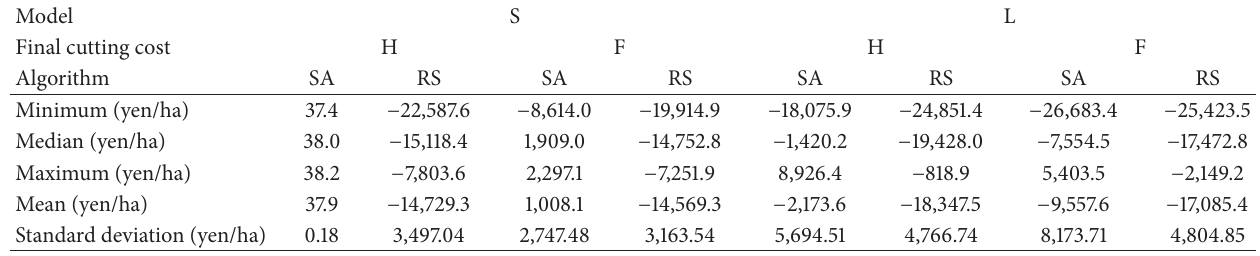
Table 2: Differences between optimal NPVs produced by SA and RS and that derived using CFE.